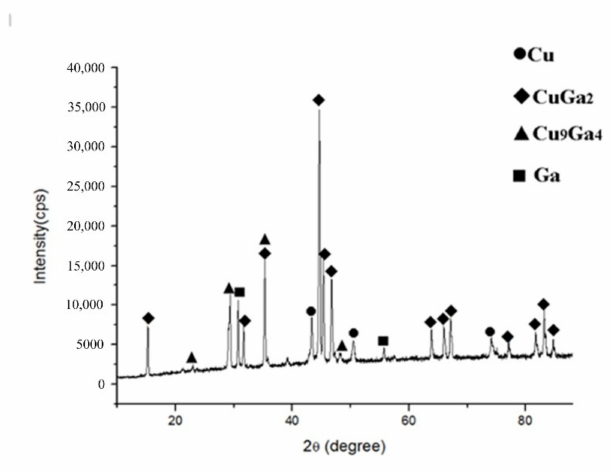
Figure 6. XRD results of the intermediate